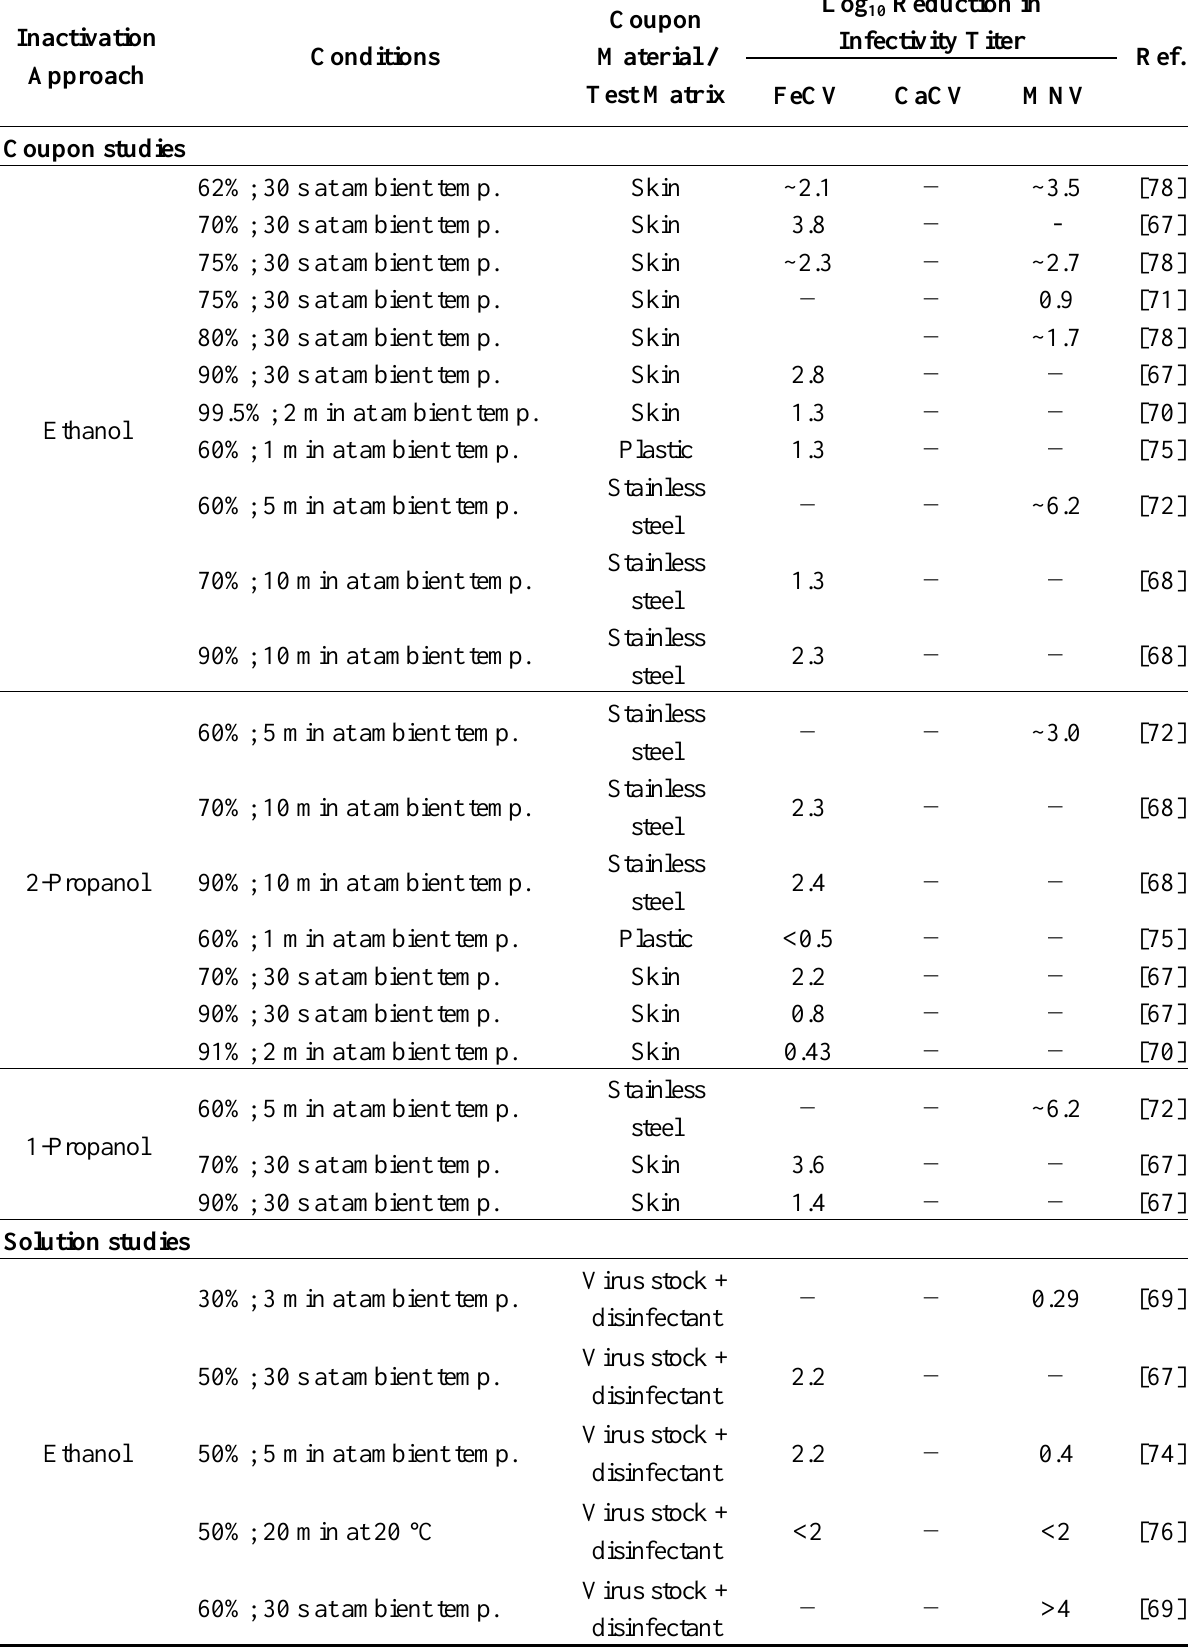
Table 6. Inactivation of caliciviruses by